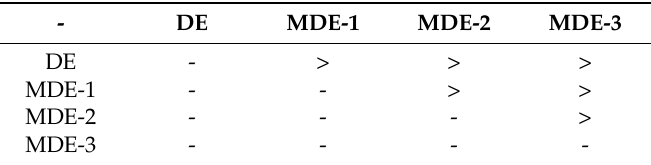
Table 17. The statistic test for the proposed